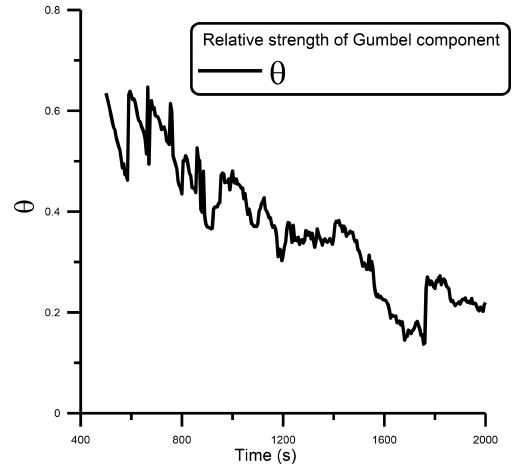
Figure 2. Time evolution of the coefficient θ in Eq. (6), obtained for a simulation with the product